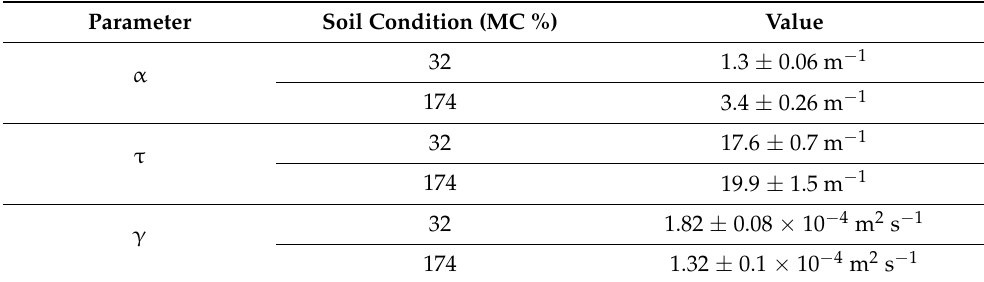
Table 2. Soil parameter values used to model soil temperature during comb slow-wave experiments (Note: uncertainty values represent ± the standard error for these values).